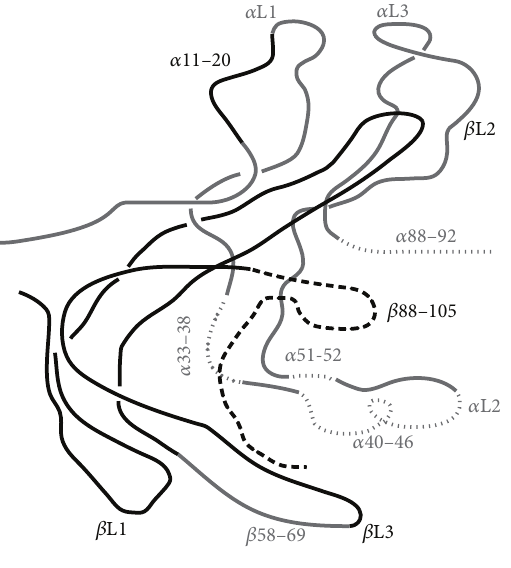
Figure 2: Structure of